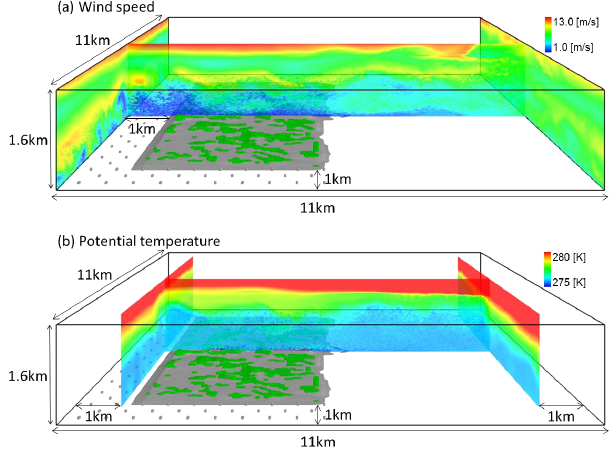
Figure 4. Instantaneous fields of (a) wind speed and (b) potential temperature.